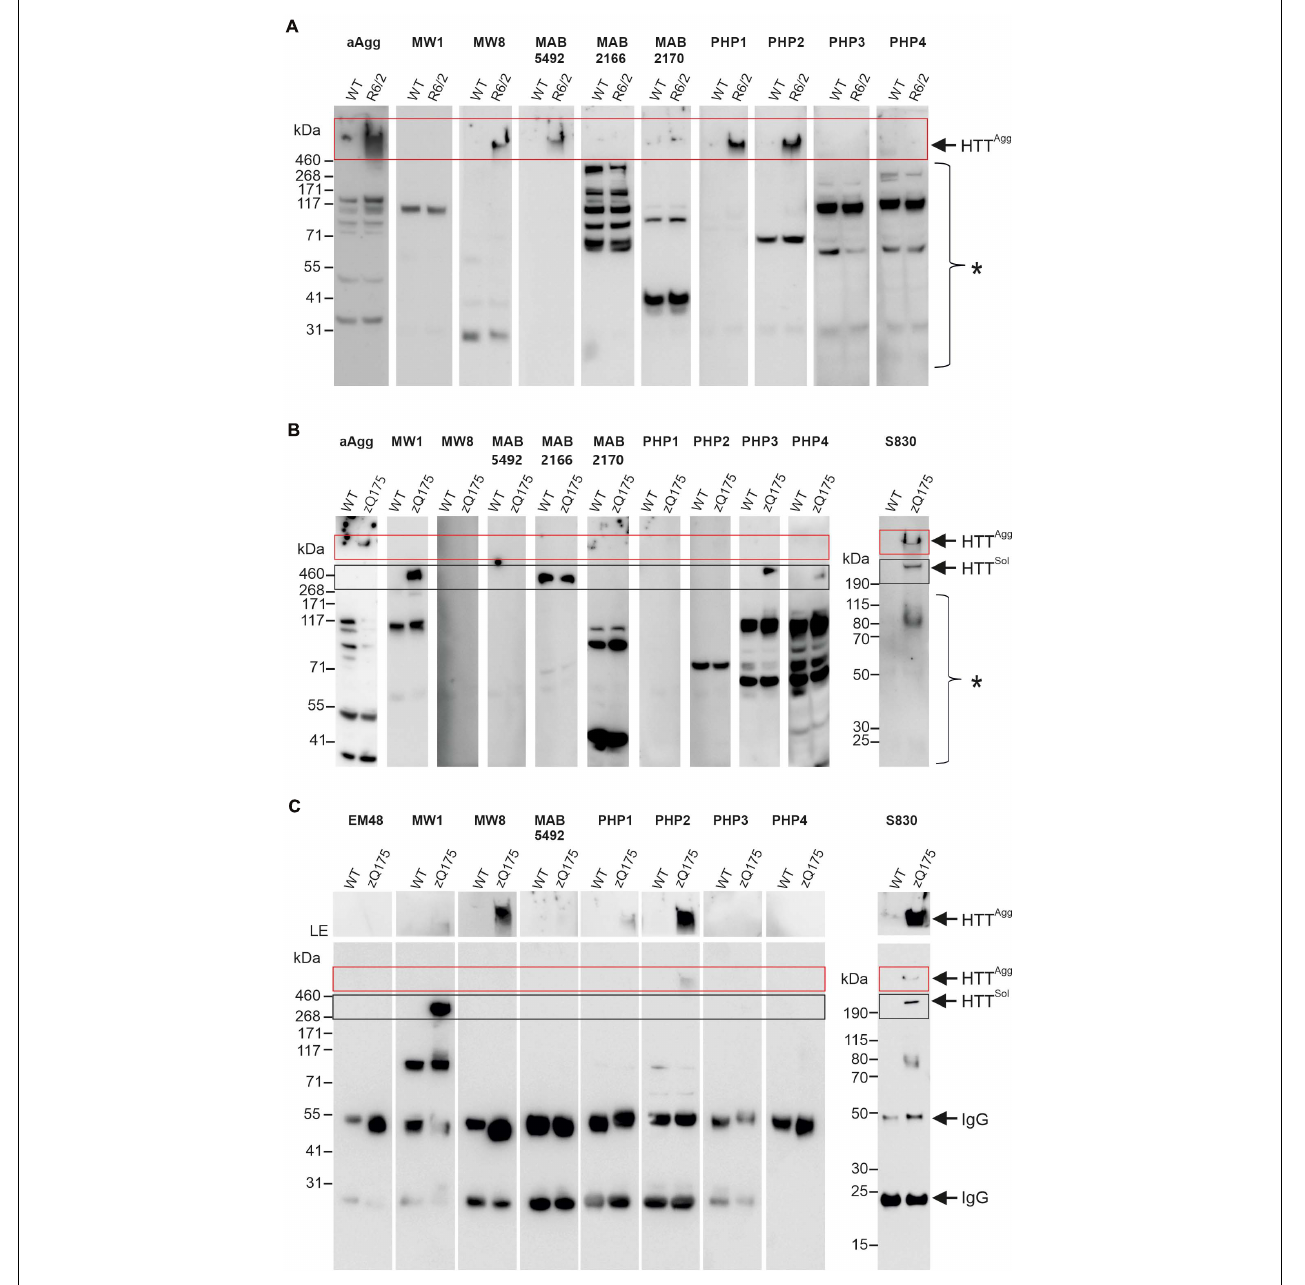
FIGURE 2 | Analysis of mHTT aggregates and soluble protein in brain homogenates from R6/2 and zQ175 mice. (A) 50 µ g of total brain homogenates prepared from 12-week-old R6/2 and wild-type (WT) mice were analyzed on a denaturing NuPage gel and by immunoblotting using the antibodies indicated above the lanes. For preparation of brain homogenates, BLB was used. HTT Agg and a red box indicate mHTT aggregates in the gel pockets. A bracket with an asterisk indicates immunoreactive bands which cannot be assigned to specific proteins. (B) 100 µ g of total brain homogenate prepared from 12-month-old zQ175 and wild-type (WT) mice was analyzed on a denaturing NuPage gel and by immunoblotting using the indicated antibodies. For preparation of brain homogenates RIPA buffer was used. HTT Agg and a red box indicate mHTT aggregates in the gel pockets. HTT sol indicates soluble ∼ 350 kDa HTT protein. A black box indicates soluble HTT, migrating at the expected size of ∼ 350 kDa. A bracket with an asterisk indicates immunoreactive bands which cannot be assigned to specific proteins. (C) Immunoprecipitations using different antibodies, as indicated on top of the gels; total brain homogenates (in BLB) derived from 12-month-old zQ175 and wild-type (WT) mice were applied. Immunoblots were developed with the respective antibodies used for immunoprecipitation and exposed for 20 s, with the exception of the S830 immunoblot, which was exposed for 30 s. The upper parts of blots were exposed separately for 5 min, to better visualize mHTT aggregates. LE, long exposure. HTT Agg and a red box indicate mHTT aggregates in the gel pockets. HTT sol and a black box indicate soluble FL HTT protein migrating at ∼ 350 kDa. IgG indicates heavy ( ∼ 50 kDa) and light ( ∼ 25 kDa) antibody chains.